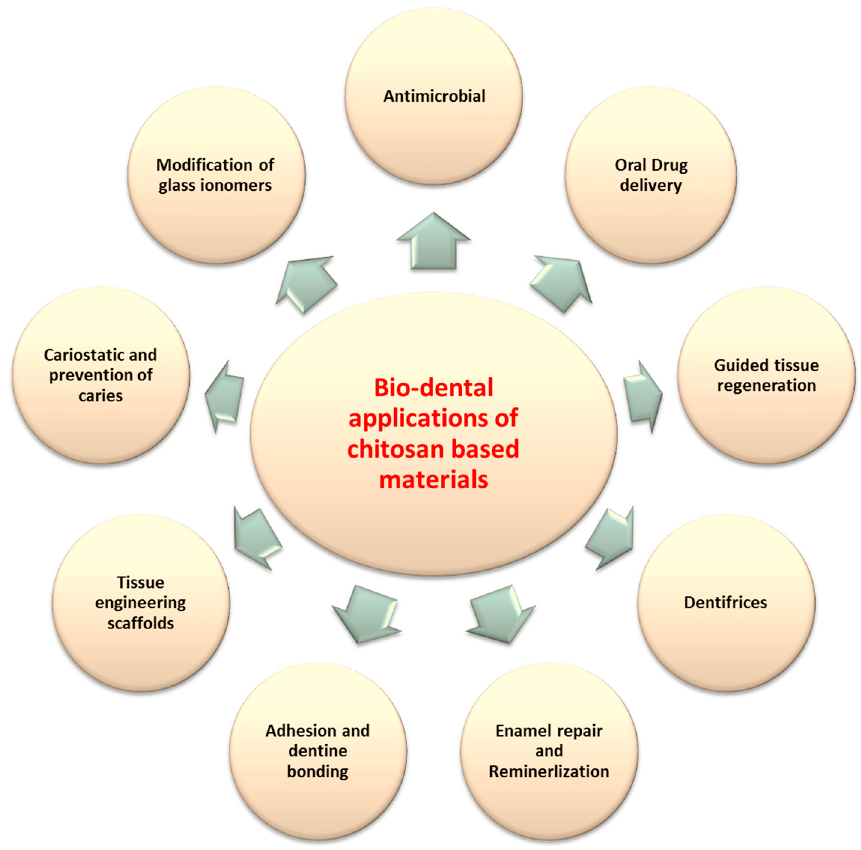
Figure 4. Current and potential applications of chitosan materials in dentistry.